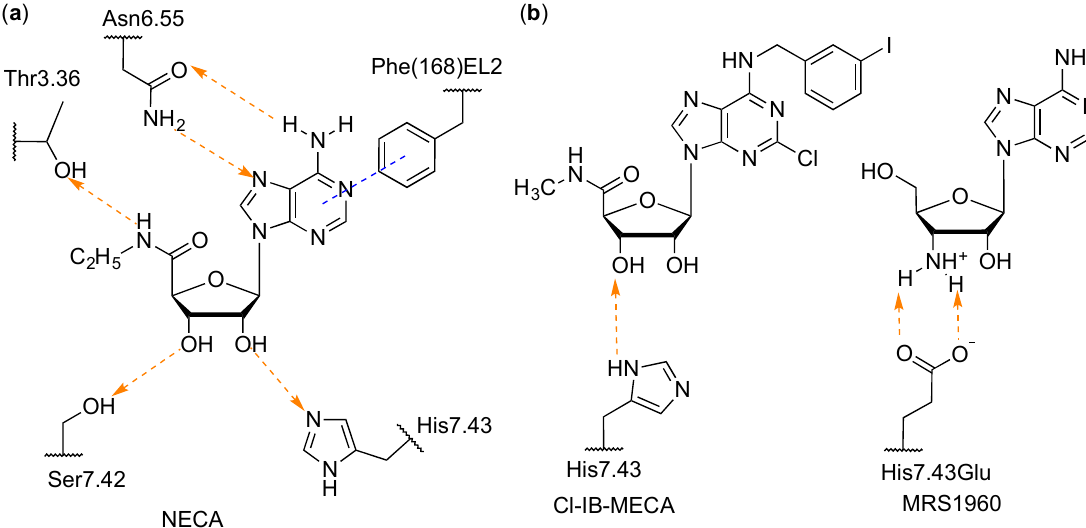
Figure 4. ( a ) Contacts of NECA 2 when docked in the hA 3 AR (using Ballesteros–Weinstein notation [32]). The residue numbers are Thr94 (3.36), Asn250 (6.55), His272 (7.43) and Ser271 (7.42); ( b ) Schematic depiction of the neoceptor approach at the A 3 AR: comparison of the binding of Cl ‐ IB ‐ MECA 9 at the wild ‐ type hA 3 AR (left) with the binding of neoligand MRS1960 3 at the His7.43Glu mutant A 3 AR (right) [24]. Orange arrows denote H ‐ bonds, while blue lines π‐π stacking interactions.